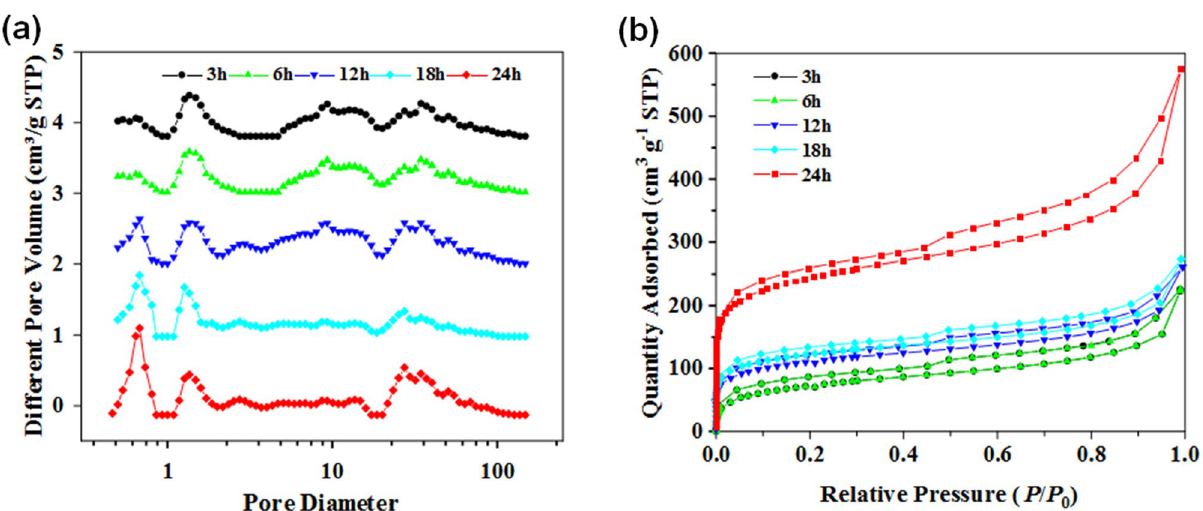
Figure 4. ( a ) DFT pore size distributions and ( b ) N 2 adsorption desorption isotherms of HPP with different hypercrosslinking